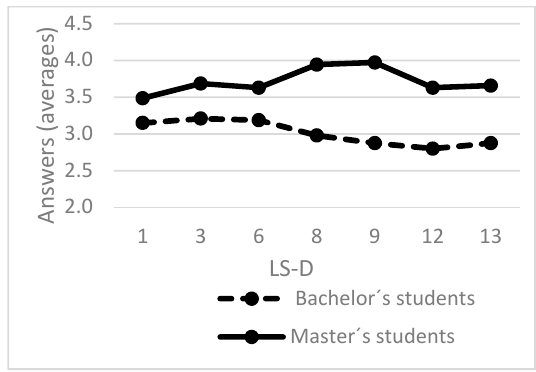
Figure 3. Answers of undergraduate and graduate students in LS-D.